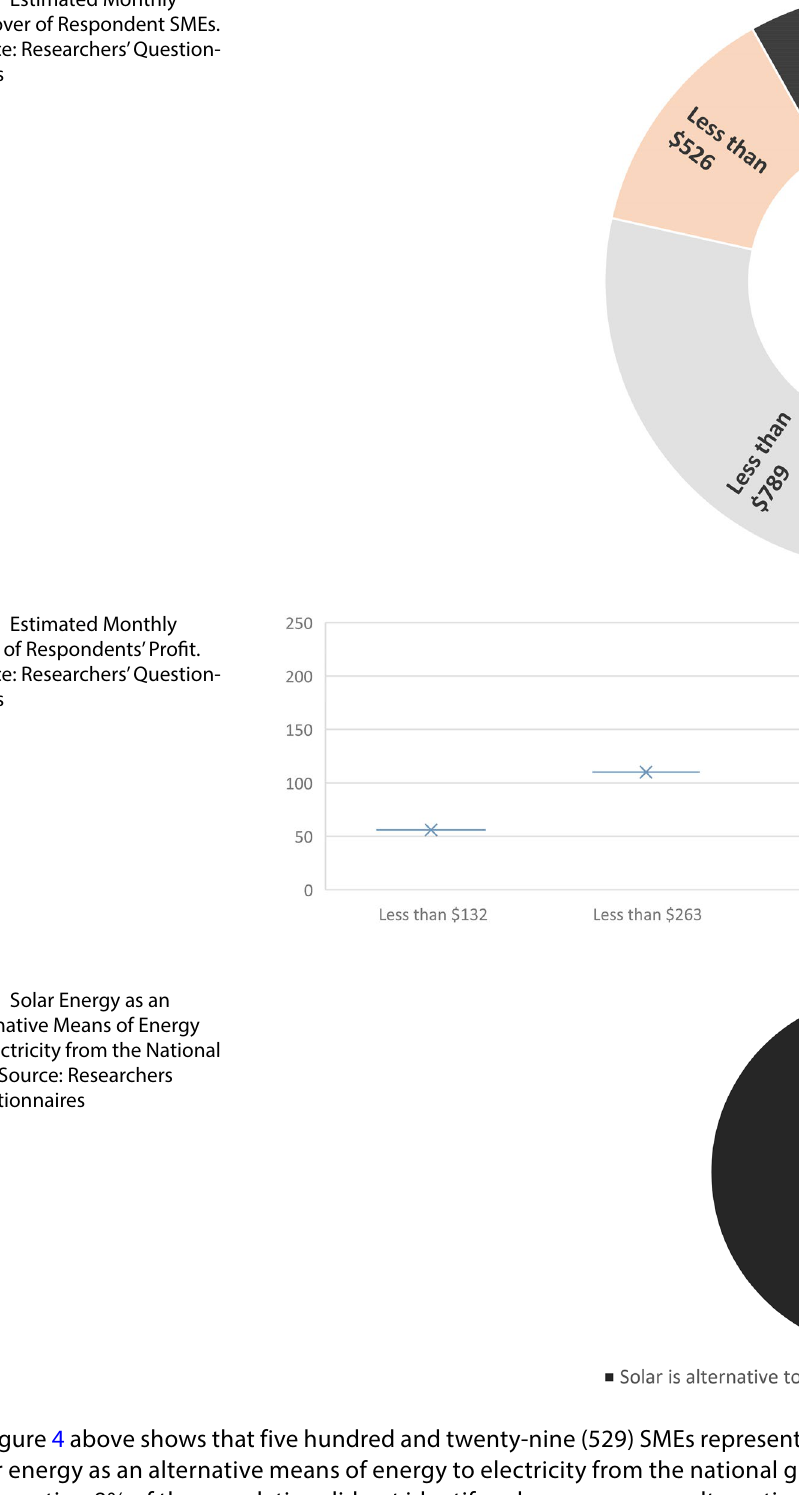
Fig. 2 Estimated Monthly Turnover of Respondent SMEs.